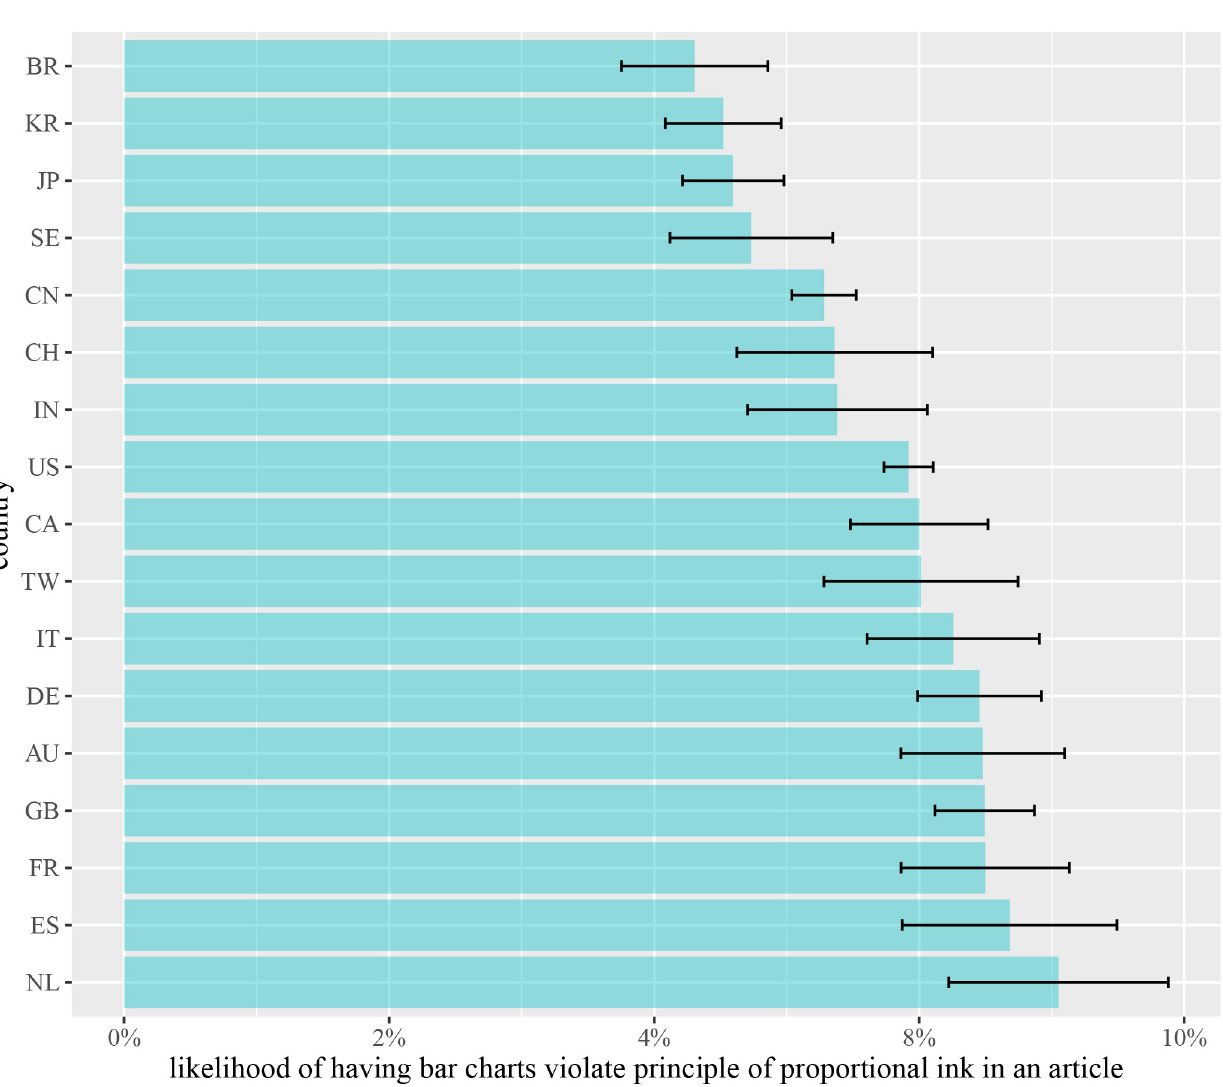
Fig 5. The likelihood of having graphical integrity issues across each country. Top three countries as the Netherlands, Spain, and France.